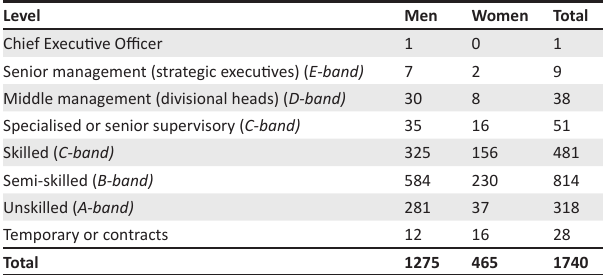
TABLE 1: Total number of